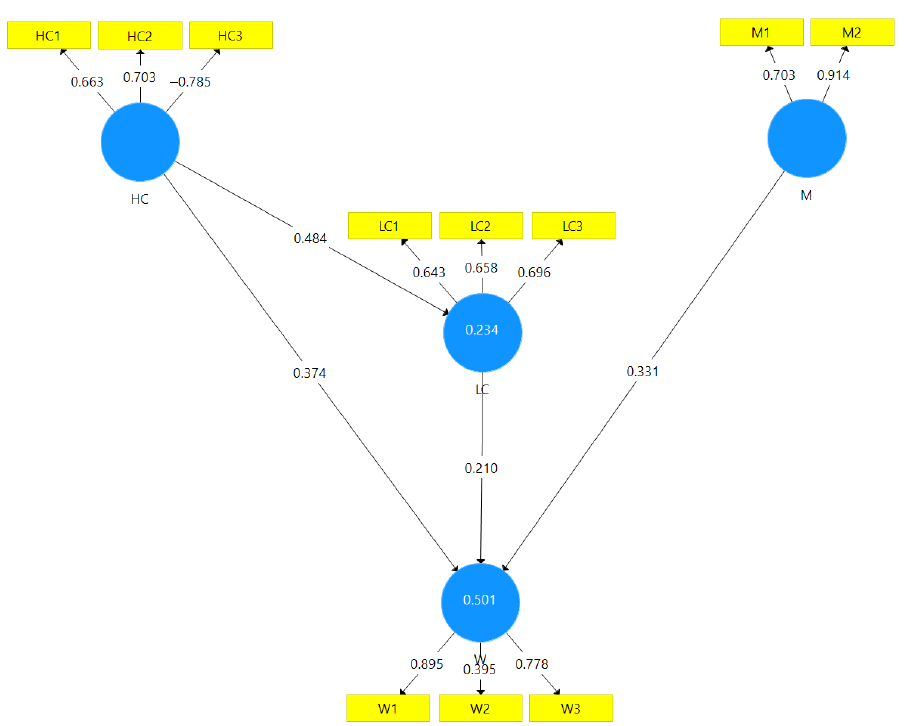
Figure 1. Proposed exploratory model. Source: Authors.